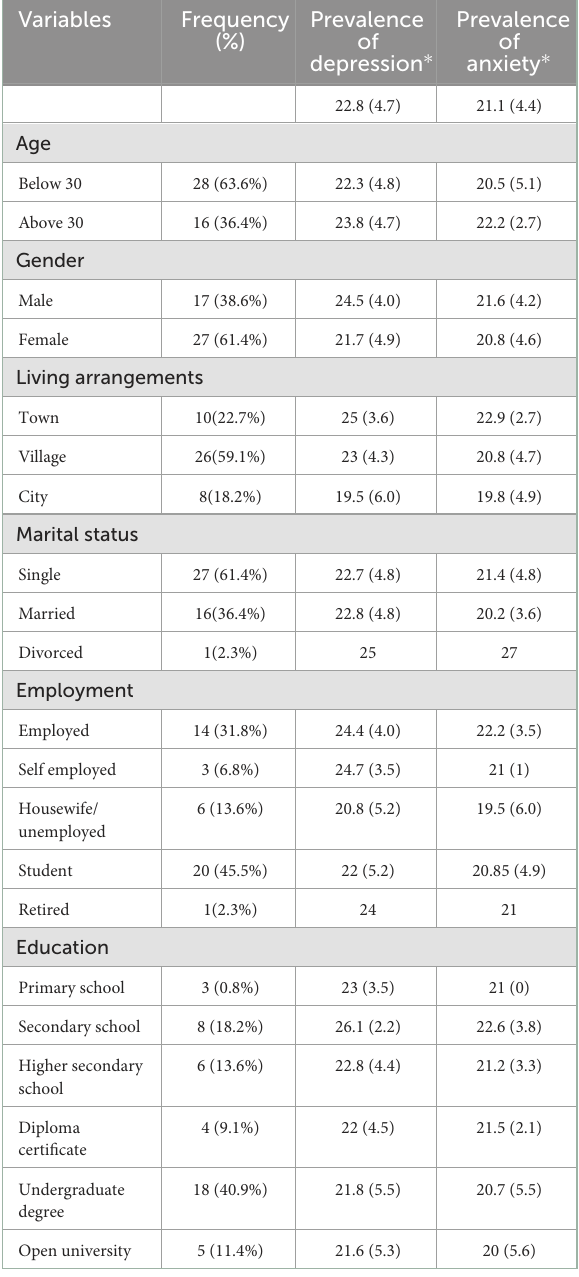
TABLE 1 Characteristics of participants ( n =